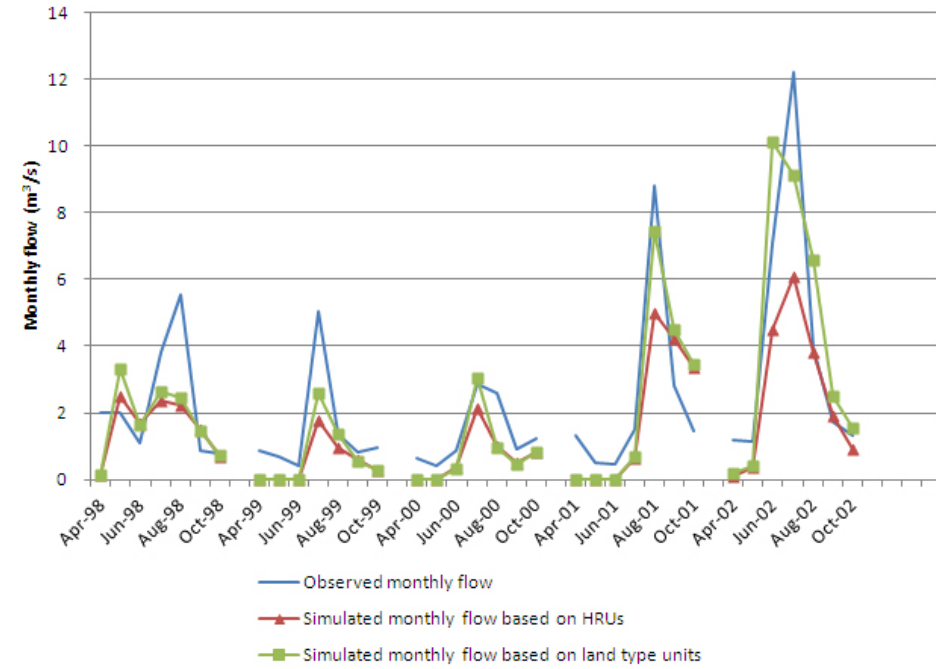
Fig. 3. Observed and simulated monthly